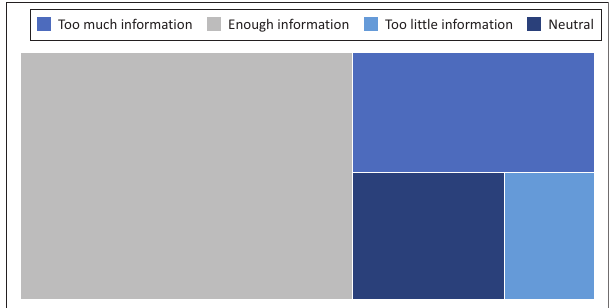
FIGURE 4: Perceptions regarding the amount of information about coronavirus disease 2019 shared in the media.